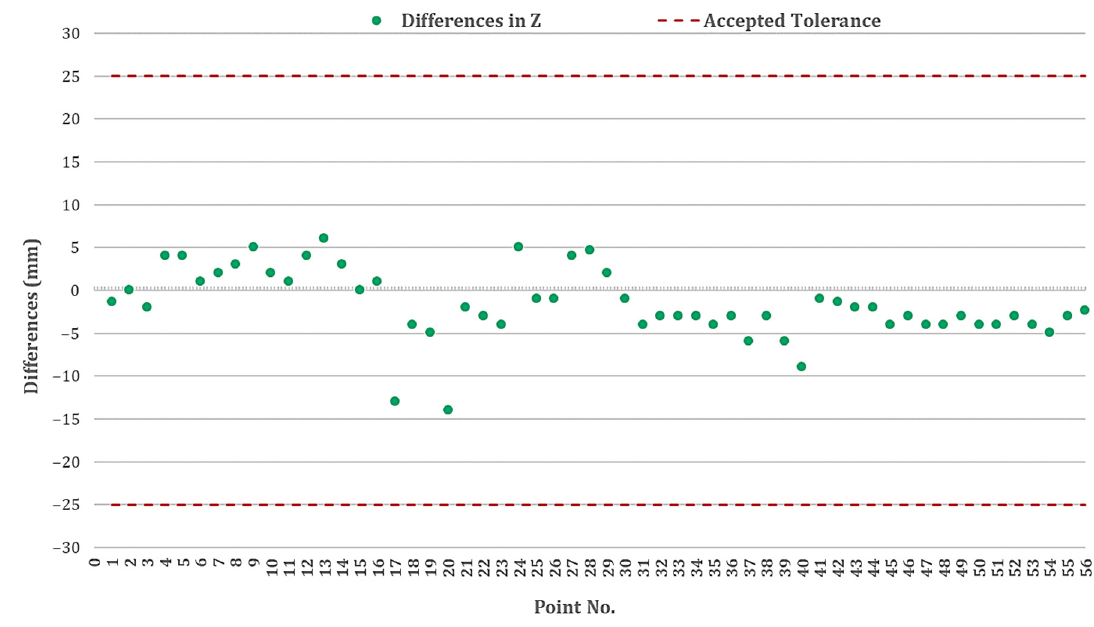
Figure 8. Differences between the extracted points by the proposed method and known coordinates on the X and Y axes of the first test.